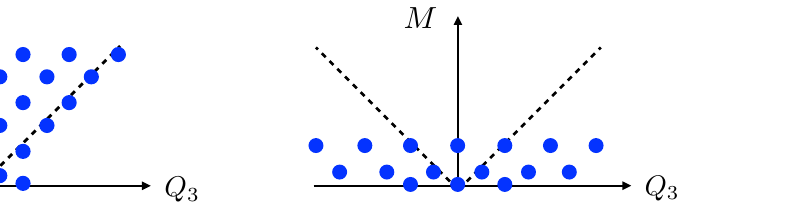
Fig. 1 The nonabelian sLWGC (left) and abelian sLWGC (right) for an SU ( 2 ) gauge group. For a sublattice of fixed index, the nonabelian sLWGC requires many more particles charged under the U ( 1 ) Cartan